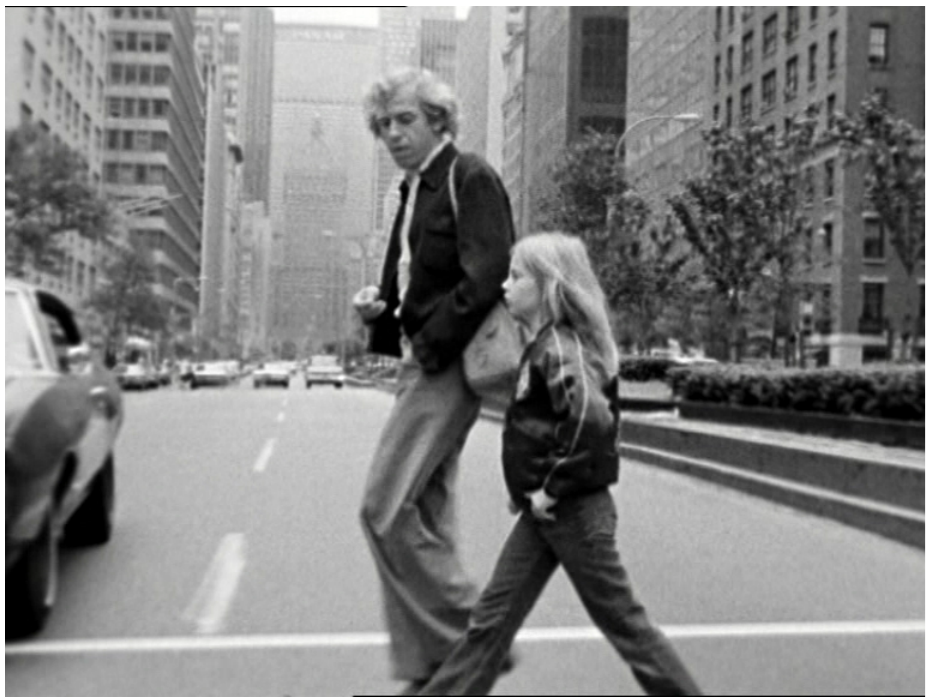
Figure 1: Alice in the Cities